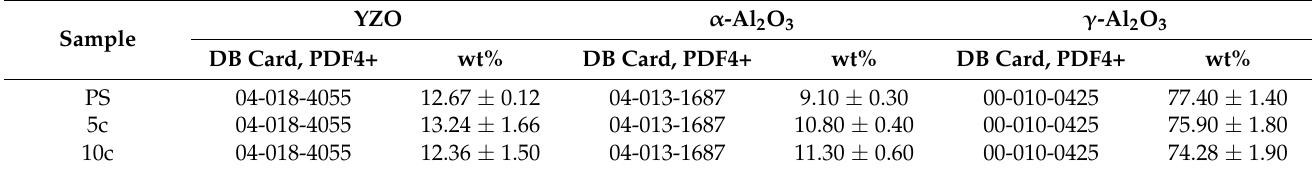
Figure 5. Representative XRD patterns and crystalline phase composition of plasma sprayed sample (a), 5 cycles at 1000 °C sample (b) and 10 cycles at 1000 °C sample (c). Table 1. Phase composition and phase ratio of the analyzed coatings.